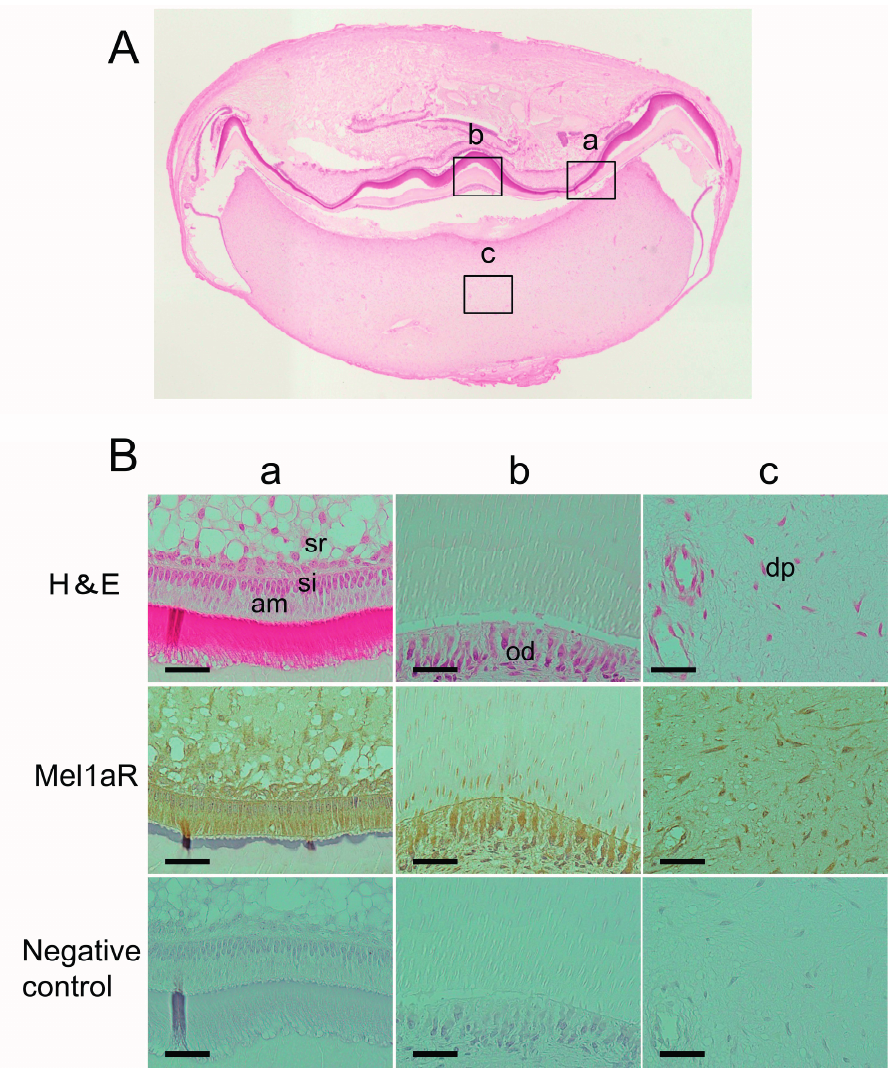
Figure 1. ( A ) Transverse section of a human tooth germ stained with hematoxylin and eosin (H&E). Higher magnification views of several portions of the tooth germ indicated by alphabetized squares were shown in panel B; and ( B ) Higher magnification views of characteristic areas of the tooth germ. Mel1aR was noted to be expressed in ameloblasts (am), stratum intermedium cells (si), stellate reticulum cells (sr), odontoblasts (od) and dental papilla cells (dp). H&E: hematoxylin and eosin staining. Mel1aR: 3,3'-diaminobenzidine (DAB) and hematoxylin staining. Negative control: normal mouse IgG. Scale bars = 25